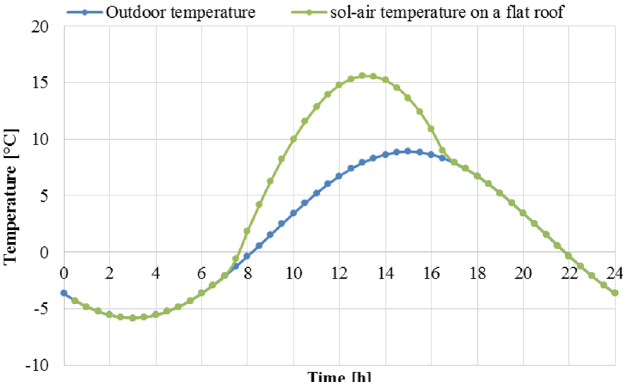
Fig. 9. Graphical representation of the outdoor temperature and the sol-air temperature on a horizontal surface.